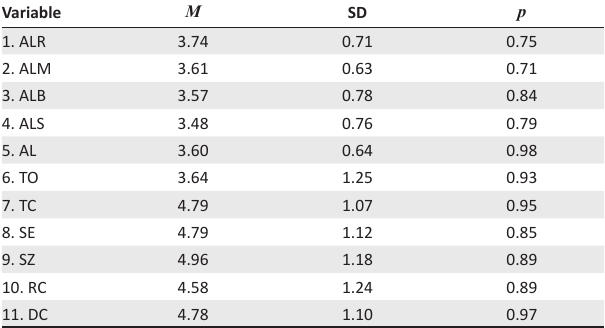
TABLE 4: Correlation matrix including means, standard deviations and reliabilities.